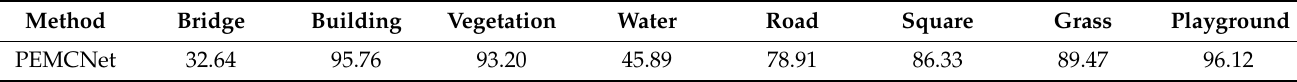
Table 6. Classification accuracy of each class of PEMCNet on the test set of GDUT-S3D dataset in terms of IoU (%). Method